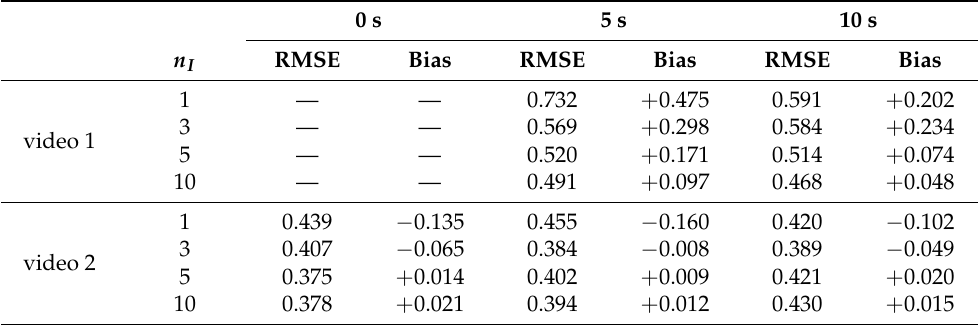
Table 2. Influence of the number of basis images, n I , and the filtering characteristic time t f , on Root Mean Square Error (RMSE) and bias of the retrieved bathymetry where ε (cid:54) ε 0 . 0 s 5 s